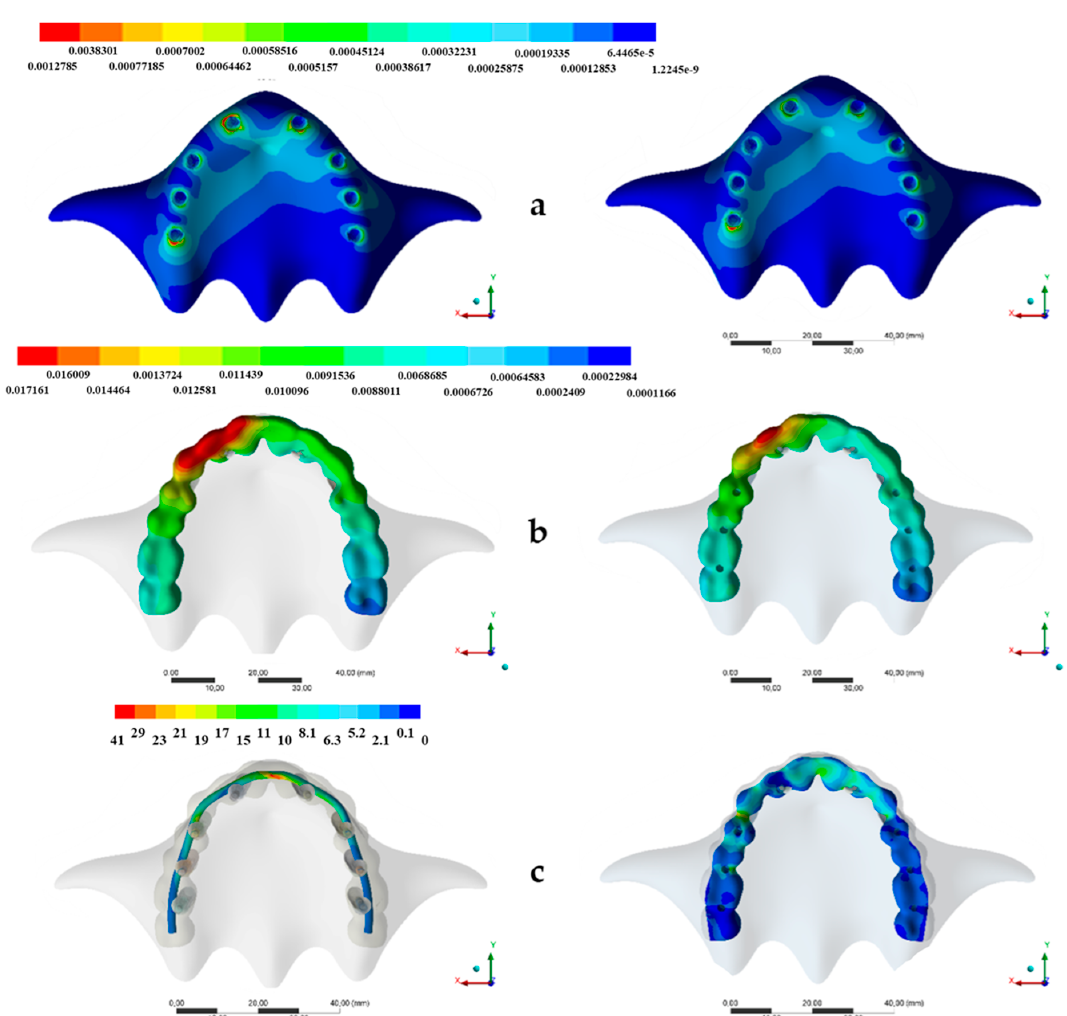
Figure 3. ( a – c ) Stress maps for the framework according to each design. Left: Conventional design based on a casted CoCr framework and acrylic resin. Right: The prosthesis experimental design. ( a ) Bone microstrain ( με ), ( b ) Prosthesis displacement (mm) and ( c ) Von Mises stress distribution.